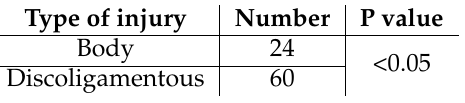
Table 3. Type of injury noted in patients